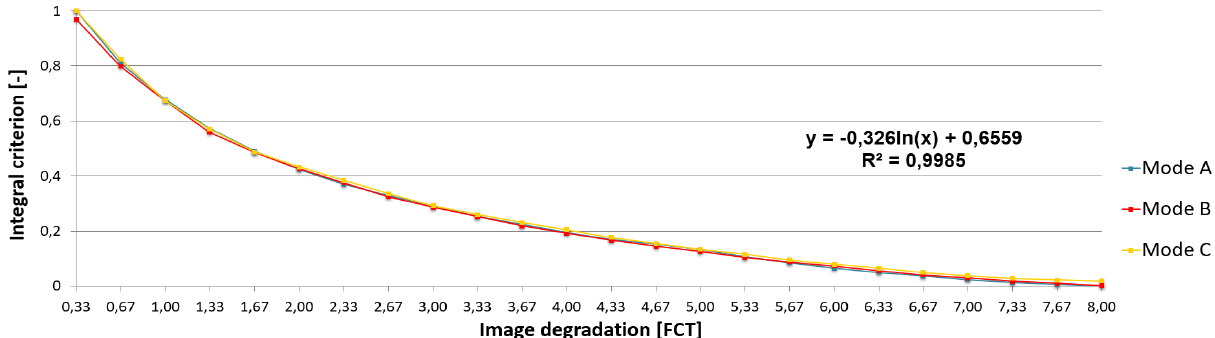
Figure 3. Objective comparison of test image degradation in three test modes by integral criterion. Mode A: parallel reduction of contrast and high spatial frequencies, mode B: isolated reduction of contrast, mode C: isolated reduction of high spatial